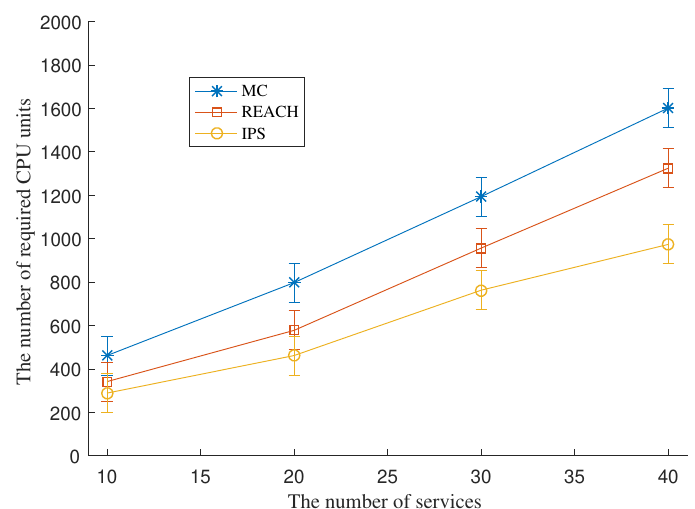
Figure 3. The number of required CPU units for redundancy deployment of MC, REACH, and IPS.